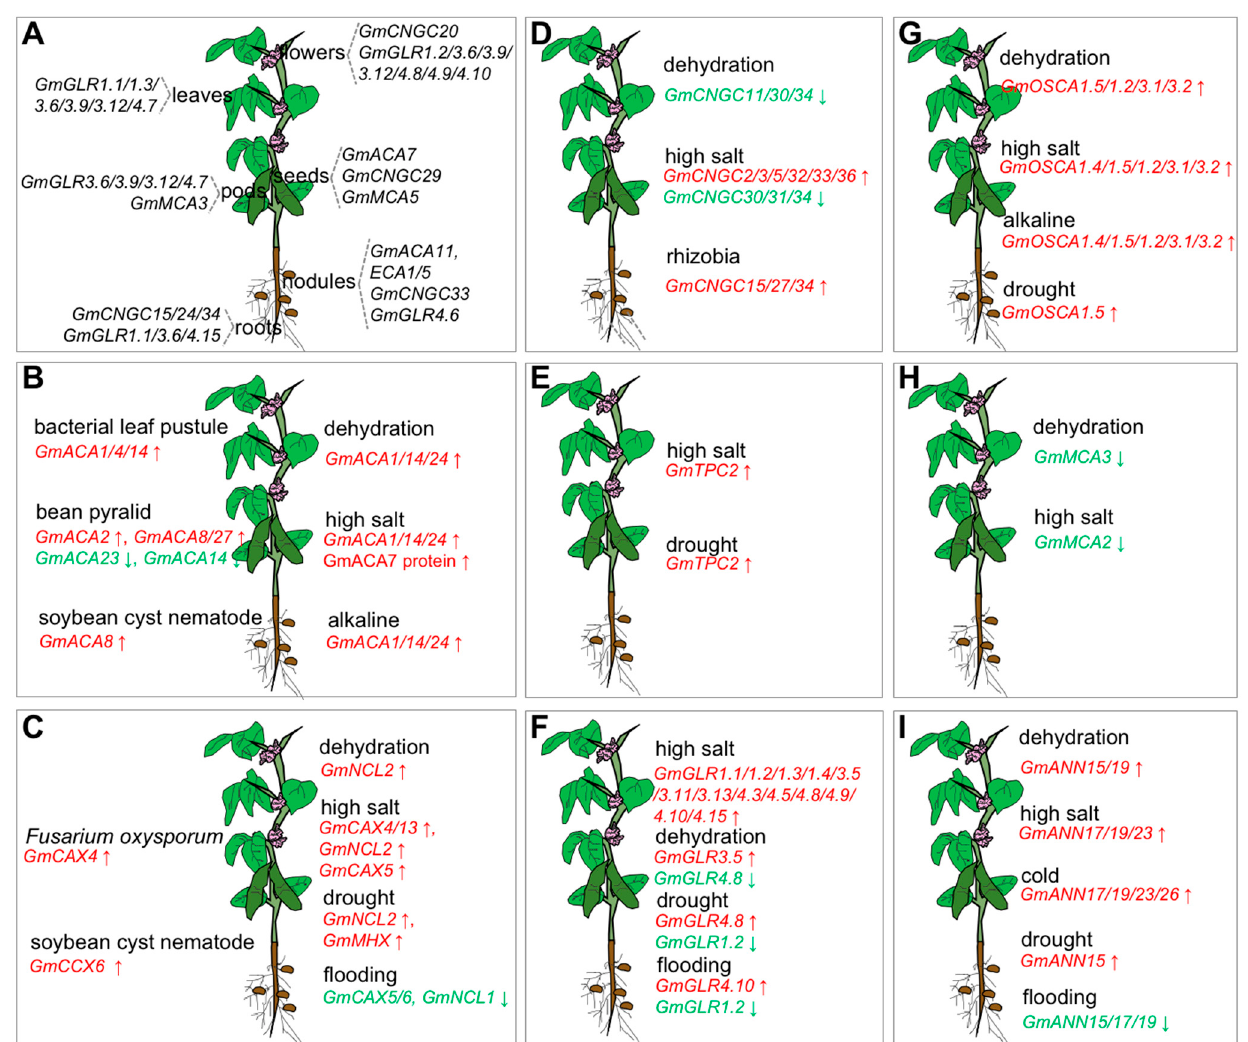
Figure 2. Schematic diagram of expression of eight soybean calcium transporters in soybean tissues ( A ) and under adverse stimuli ( B – I ). All these data were collected from published references. The red and upward arrows represent the elevation of expression. The green and downward arrows represent the decrease of expression.